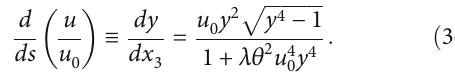
Figure 1: This fi gure illustrates the setup used. The probe brane is placed at a fi nite position ( u probe brane, the placement of the Wilson loop is shown in (a), arrows indicating the contour of the loop (not the propagation of the string). For adiabatic interactions, one can neglect the e ff ects of the dotted lines and the string pro fi le becomes